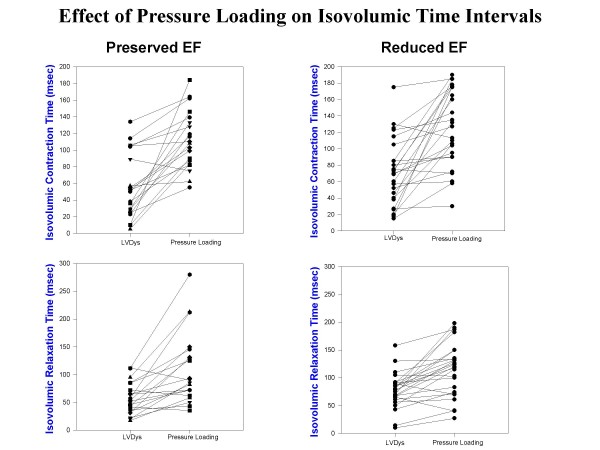
Isovolumic contraction time at baseline LV dysfunction (LVDys) and following pressure loading in dogs with LV dysfunction and preserved ejection fraction (left upper) and LV dysfunction with reduced ejection fraction (right upper) demonstrates similar extent of increases with pressure loading. Similarly, the isovolumic relaxation period at baseline LV dysfunction (LVDys) and following pressure loading in dogs with LV dysfunction and preserved ejection fraction (left lower) and LV dysfunction with reduced ejection fraction (right lower) demonstrates a similar degree of lengthening with pressure loading.